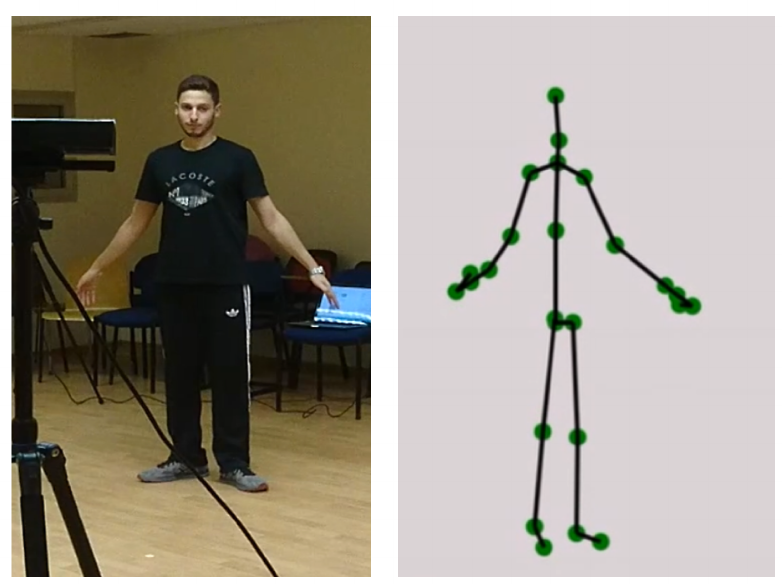
Figure 2. The 3D sensor ( left ) measures the distances of points in the scene from which a skeleton representation of the body pose is produced ( right